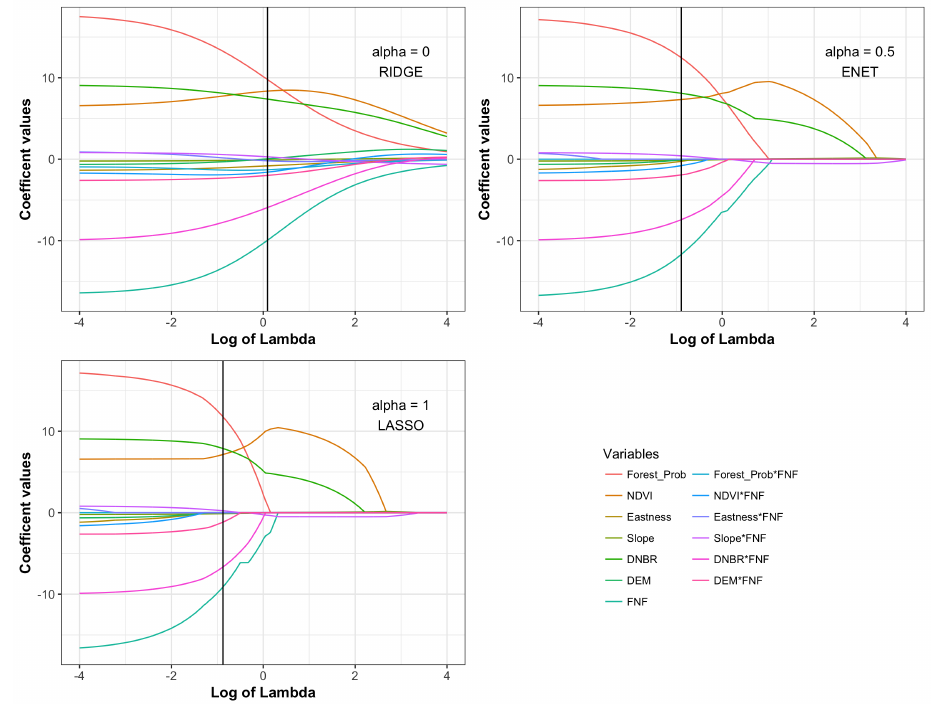
Figure 5. Coefficient paths for elastic net models of percent crown cover. The vertical bar corresponds to the lambda value chosen through